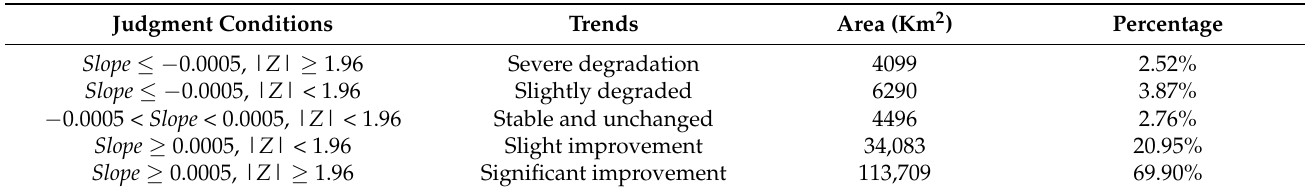
Figure 3. Spatial trends of NDVI in the Lancang River Basin. Table 1. The temporal and spatial trend of NDVI in Lancang River